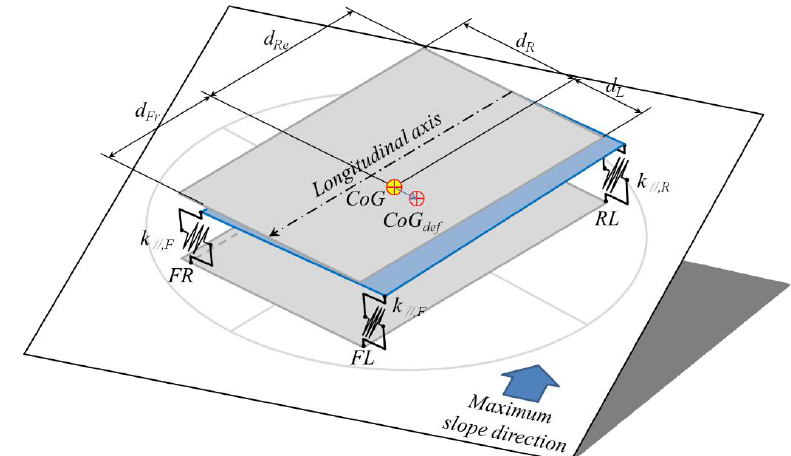
Figure 16. Graphical representation of the three-dimensional effect of a lateral deflection of the tyres due to the weight component in the direction parallel to the support plane and to the rotational axes of the wheels. In the represented case, the FL tyre is the downstream tyre.